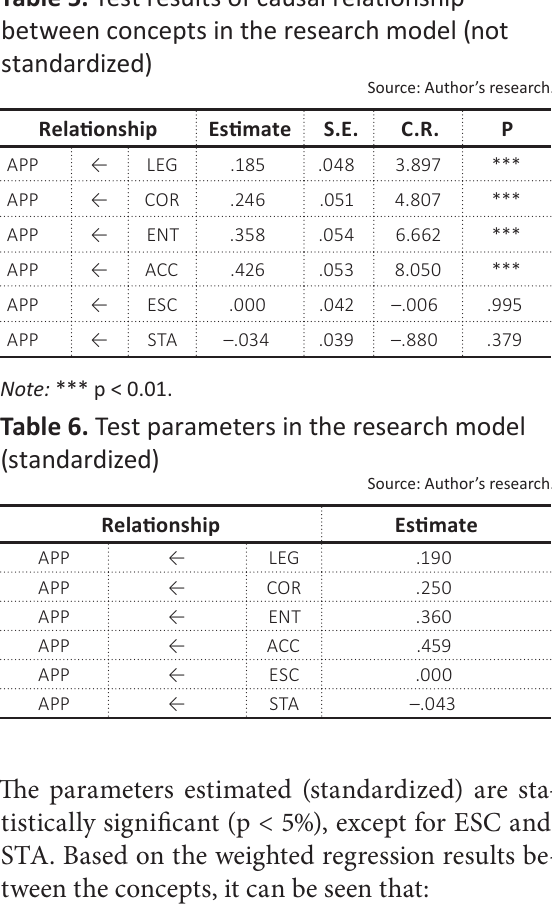
Table 5. Test results of causal relationship